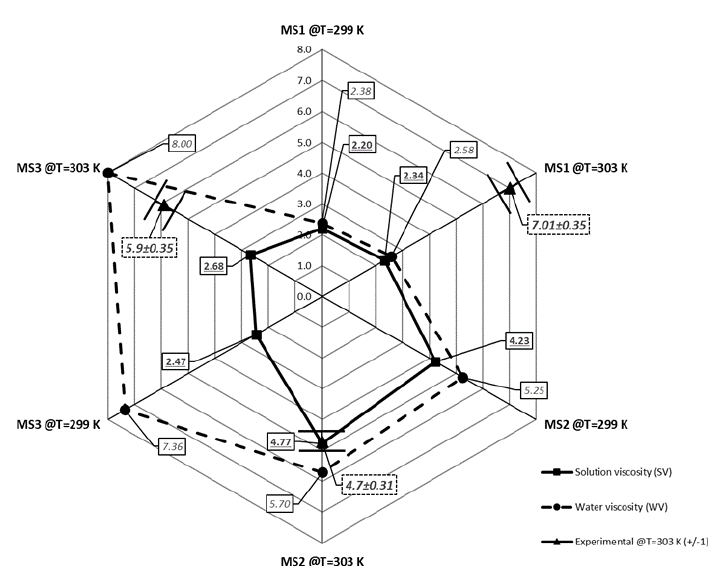
Figure 5. Comparison of calculated volume fluxes of model solutions (MS1, MS2, MS3) (10 − 5 m 3 /(m 2 ·s)) with experimental viscosities (SV) and pure water viscosities (WV) at different temperatures.